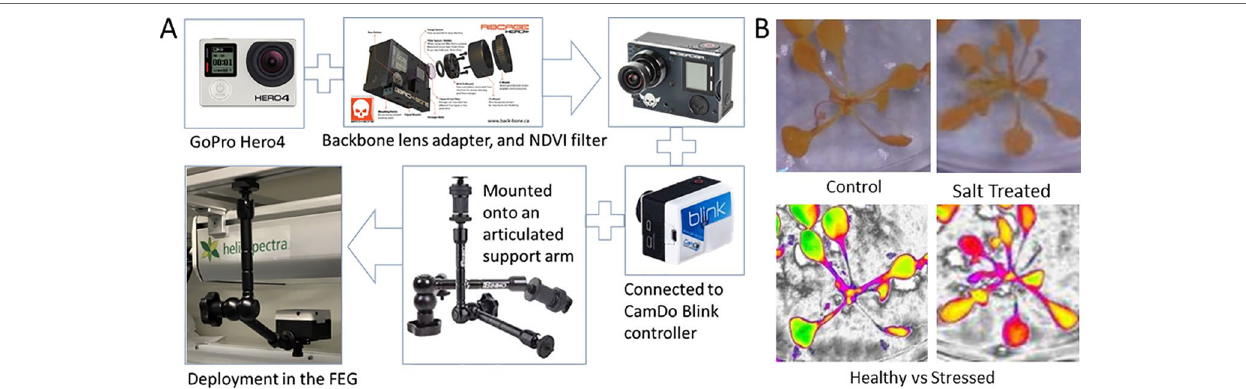
FIGUrE 8 | The basic steps involved in the assembly and deployment of the Dual Wavelength Spectral Imaging GoPro system (A) , and a test sample of images captured in healthy and salt-stressed plants, including false color NDVI renditions that use color to highlight NDVI pixel values that change with salt stress as an example (B) . (Beisel et al., 2018). The imaging filter is NDVI-7 (https://www.irmods.com/ag-ndvi-7) and the camera adaptations were from Ribcage (https://www. back-bone.ca/product/ribcage-air-hero4-mod-kit/). GoPro, Ribcage, and CamDo images taken from the company